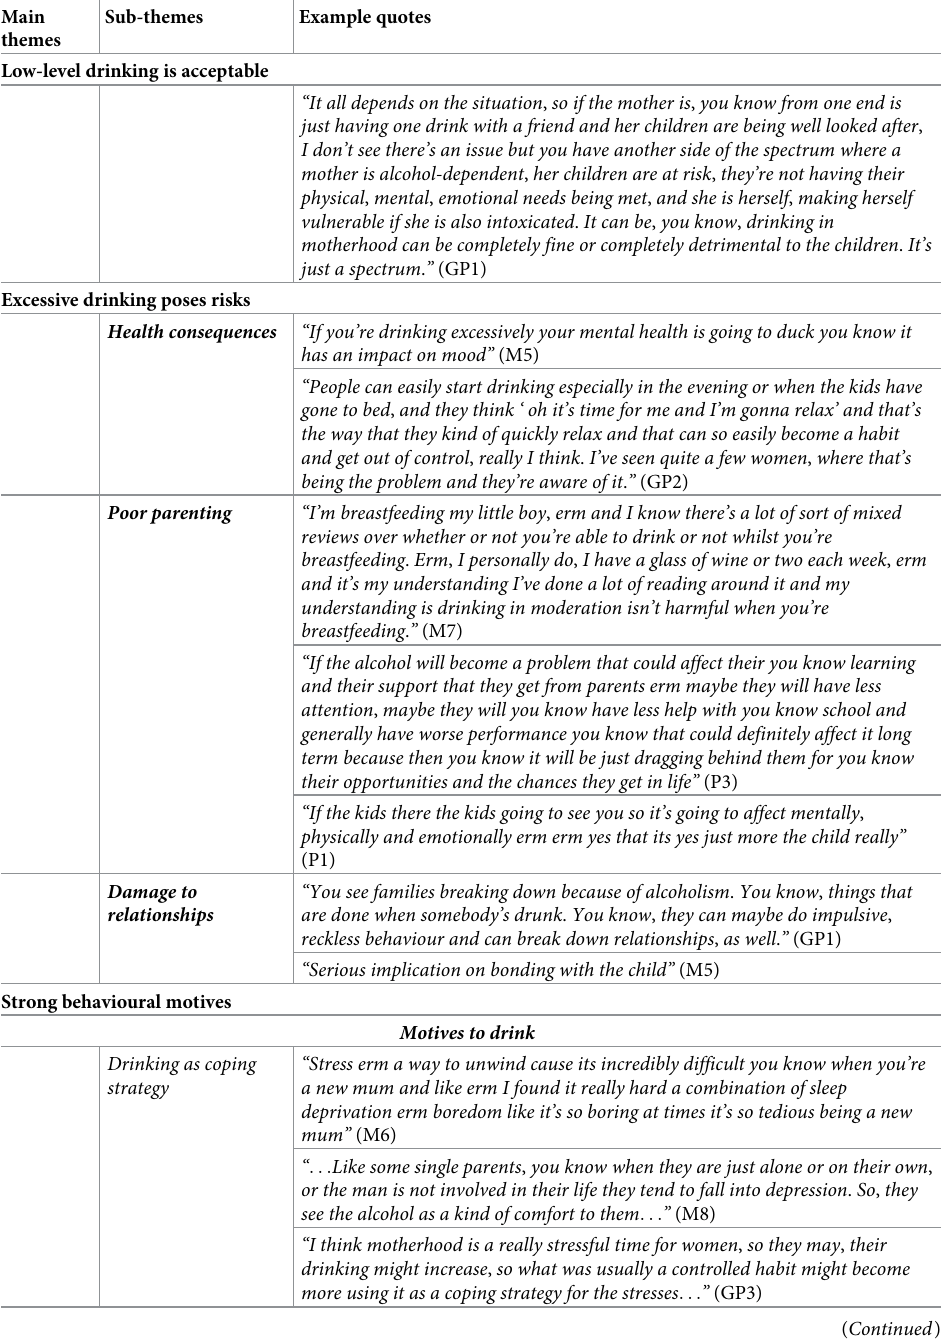
Table 2. Alcohol consumption-related views and experiences of pregnant women, mothers, and healthcare profes- sionals during